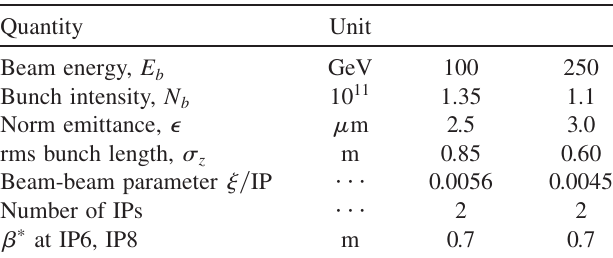
TABLE I. Main RHIC parameters achieved in polarized pro- ton operation that are relevant for beam-beam effects protons (2009). Note that the polarized proton bunch intensity is also limited by intensity dependent depolarization effects in the